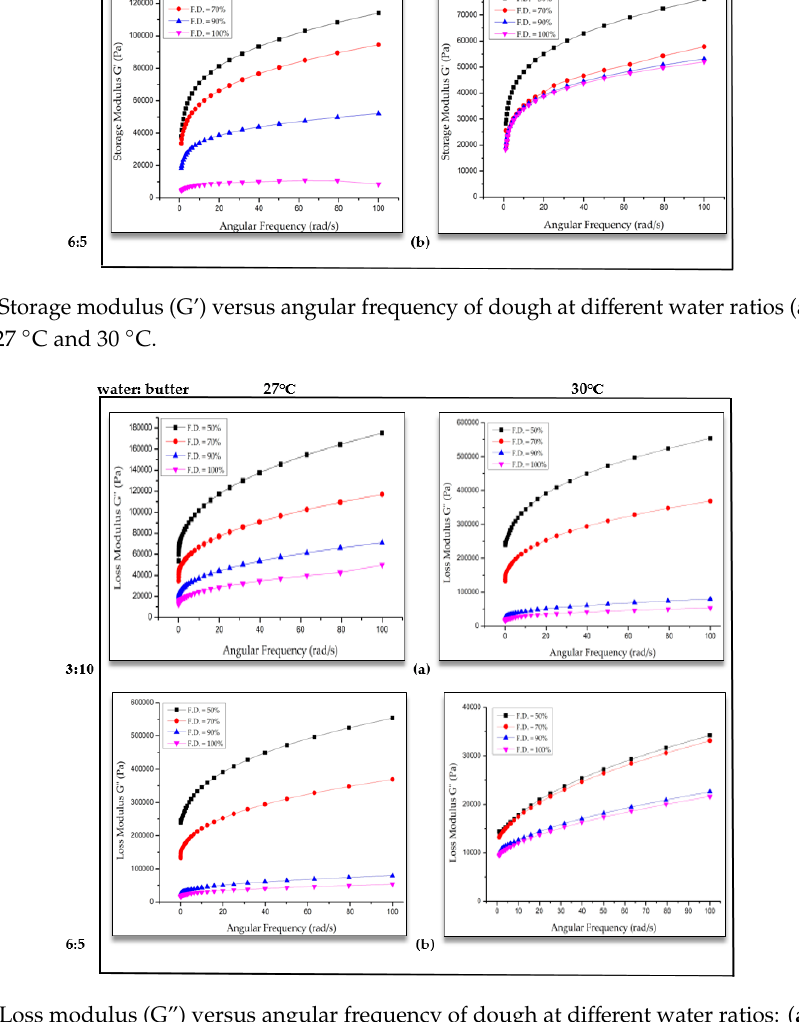
ff erent water ratios: ( a ) 3:10 and